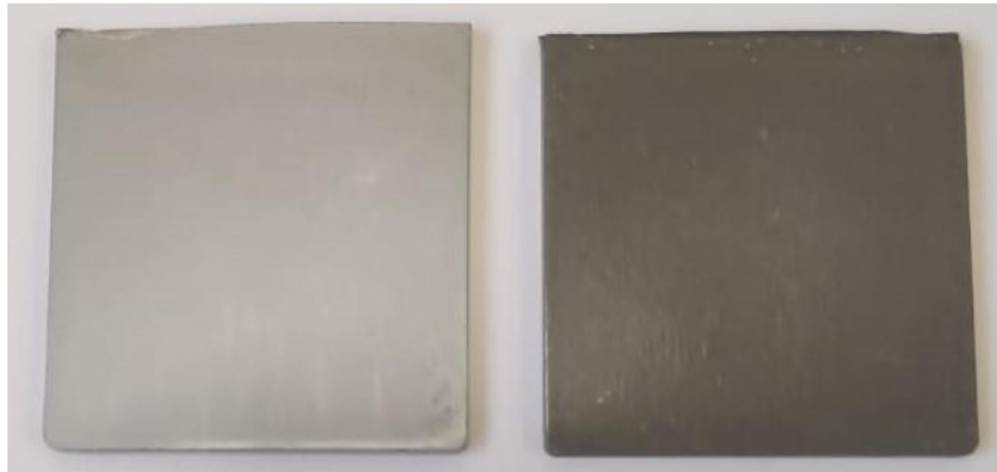
Figure 5. ( Left ): Plaque of amorphous PET with Al nano platelets is silvery. ( Right ): Plaque of amorphous PET with nodular Al particles is dark grey. The appearance is directly related to the particle shape.